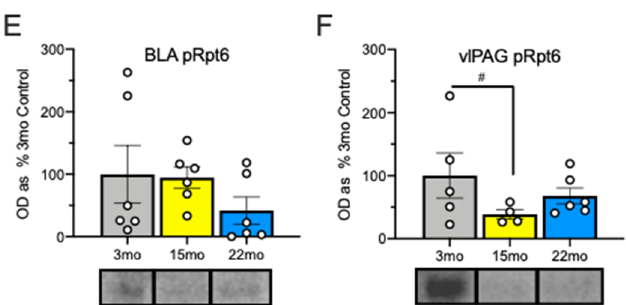
Figure 2. Rpt6 protein (pRpt6) reported as optical density as a percentage of 3-month-old control animals (mean and SEM) with representative images below group name. The 22-month-old animals showed decreased pRpt6 relative to the 3-month-old animals in the medial prefrontal cortex (mPFC) ( A ). In the retrosplenial cortex (RSC) ( B ), both the 15-month-old and 22-month-old animals showed decreased pRpt6. No di ff erences were observed in the DH ( C ). The 22-month-old animals showed decreased pRpt6 in the VH ( D ), where a trend toward a decrease was seen in the 15-month-old animals. We found no di ff erences in the basolateral amygdala (BLA) ( E ), and a trend toward a decrease in 15-month-old animals in the vlPAG ( F ). Asterisks indicate p < 0.05; pound signs indicate p < 0.10. White dots represent individual